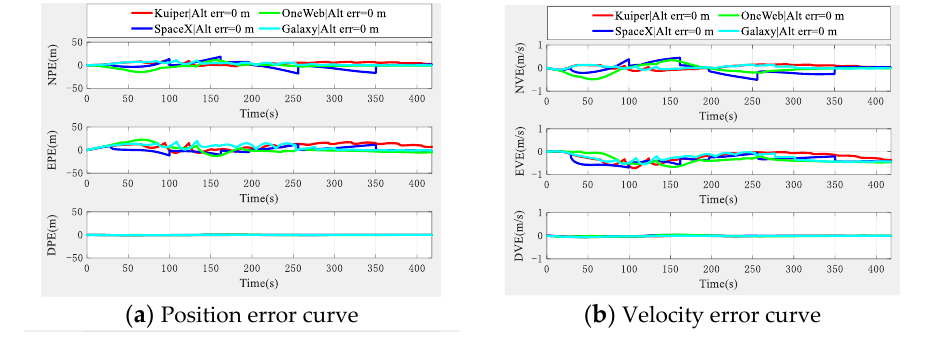
( d ) 2D projected trajectory curve Figure 14. Comparison curve of altimeter-assisted multi-aircraft cooperative navigation and posi- tioning algorithms based on the DWAPC-TSM system for different LEO constellations. Figures 13 and 14 show that regardless of altimeter assistance, due to the different parameters of each constellation, such as the inclination angle and orbit height and the distribution of satellite orbits which lead to the GDOP value and various interferences of the system, the error curve of the multi-aircraft cooperative navigation and positioning algorithm based on the DWAPC-TSM system varies slightly in individual directions. However, in general, the navigation and positioning performances for each LEO constel- lation are roughly the same, and with the aid of an altimeter, the performance of the algo- rithm is significantly improved. From the final three-dimensional trajectory curve and its corresponding projection curve, there is almost no difference between the trajectories of the LEO systems, which means that with the aid of an altimeter, the difference between the algorithms for different LEO systems is also reduced, and good cooperative navigation and positioning performance can be obtained using different LEO constellations. These results show that the proposed algorithm is generally applicable to the future LEO con- stellation scheme of integrated communication and navigation (ICN).